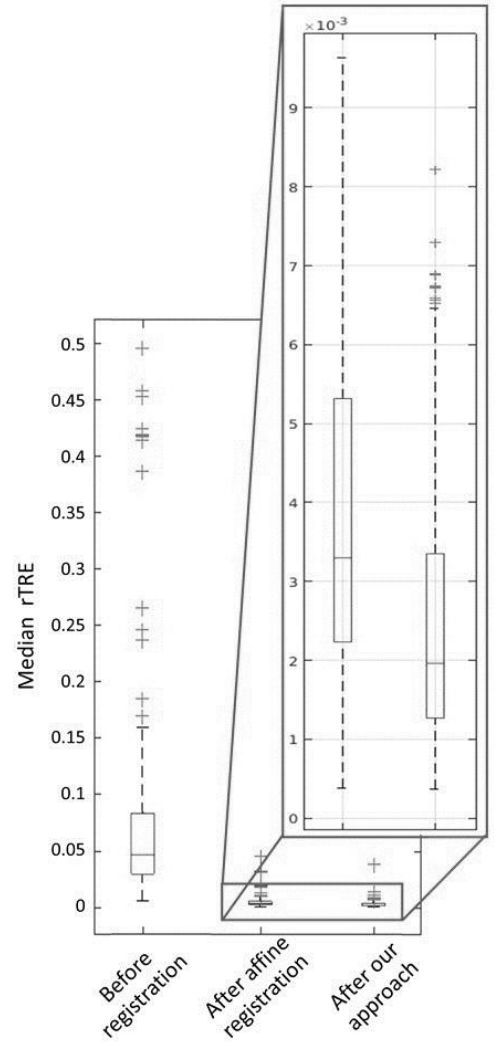
Figure 9. The overall median relative target registration error ( rTRE ) across all public data before any registration, after the affine step, and after both affine and diffeomorphic registration.